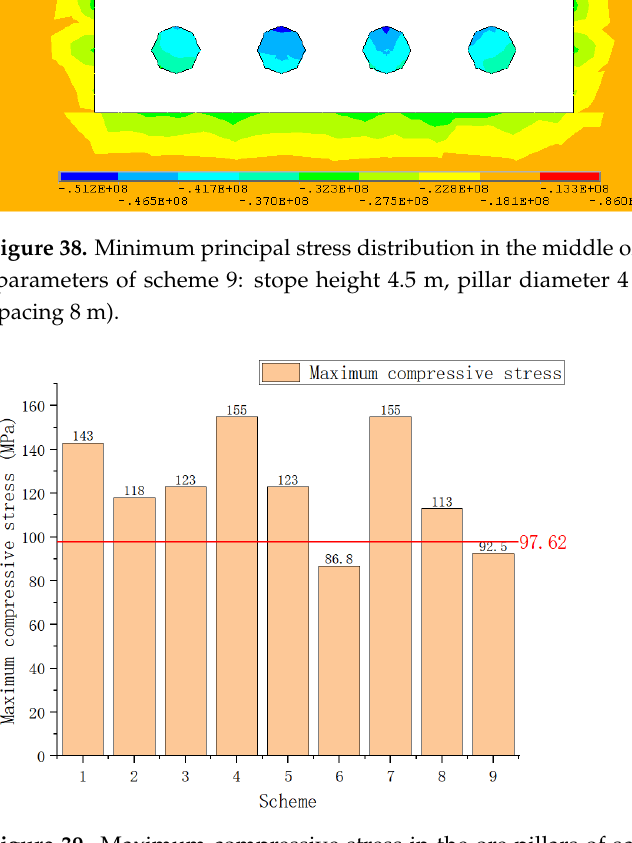
Figure 39. Maximum compressive stress in the ore pillars of schemes 1 to 9 (compared with the uniaxial compressive strength of the ore (97.62 MPa)).